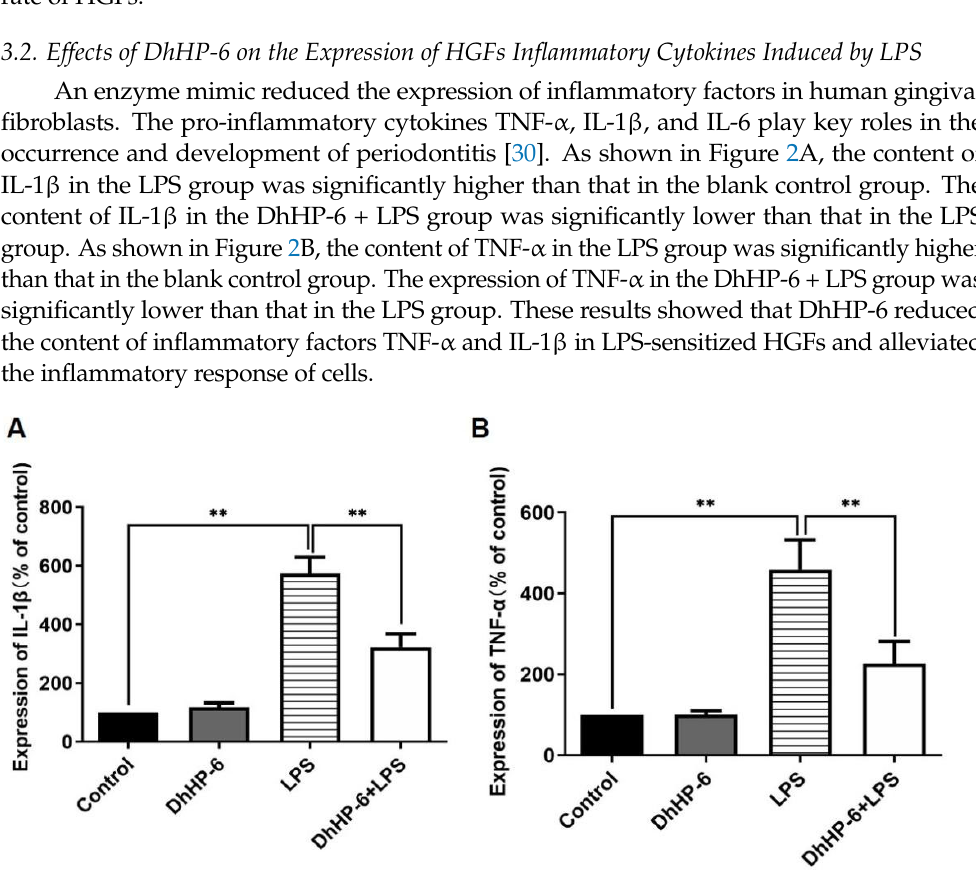
Figure 2. Expression levels of TNF- α and IL-1 β in the supernatant of HGFs induced by LPS. ( A ) IL-1 β levels in the cell supernatant; ( B ) TNF- α levels in the cell supernatant ** p < 0.01, compared with the group treated with H 2 O 2 and control.